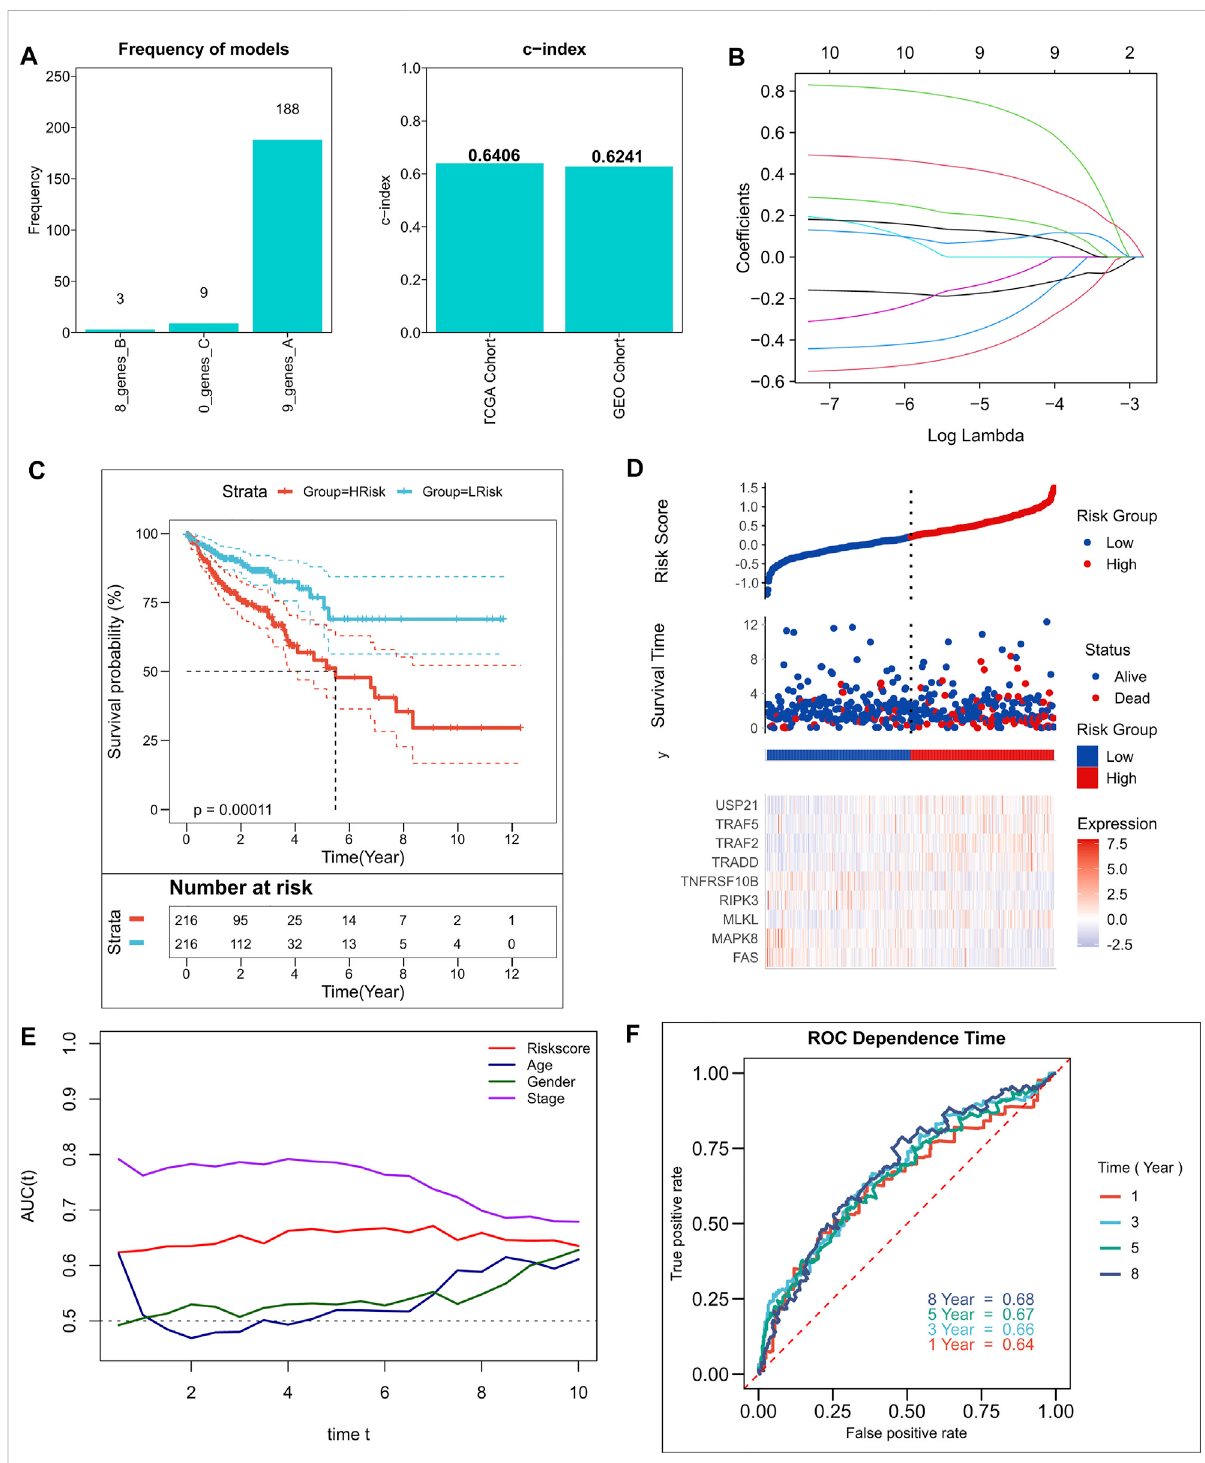
FIGURE 2 Construction of the NRGs-related risk model. (A) . Screening of the best LASSO model; left: frequency of different gene combinations in the LASSOCoxregressionmodel,right:c-indexofthebestmodelinTCGAandGEOcohorts; (B) .LASSOCoxregressionmodeltoidentifythetoprobust nine-genemarkerhavinganoptimal λ valueof0.007033; (C) .KMsurvivalcurvesforthehigh-andlow-riskgroupsinTCGAcohort. (D) .Survivalstatus ofpatientsandexpressionofmodelgenesinTCGAcohort; (E) .tROCcurvesofriskmodelsandclinicalcharacteristicsinTCGAcohort; (F) .1-,3-,5-, and 8-years ROC curves for the RiskScore in TCGA